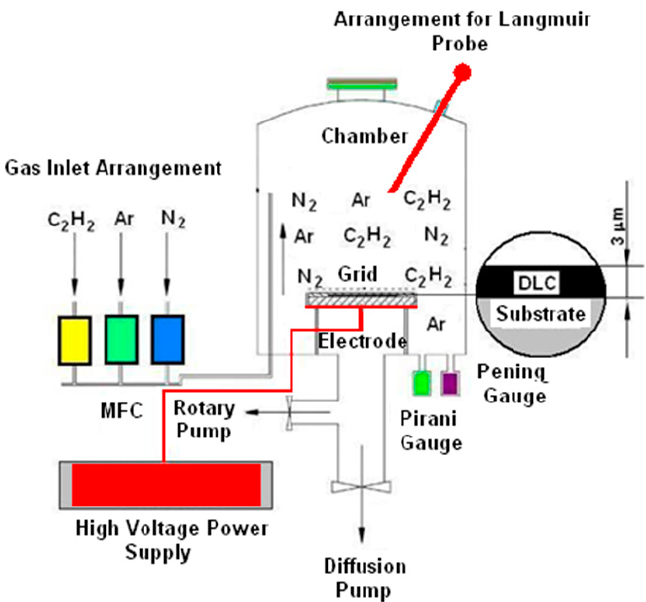
Figure 2. Diagram of equipment for the production of diamond-like carbon coating using the plasma-enhanced chemical vapor deposition (PECVD) plasma-enhanced chemical vapor deposition (PECVD) method.